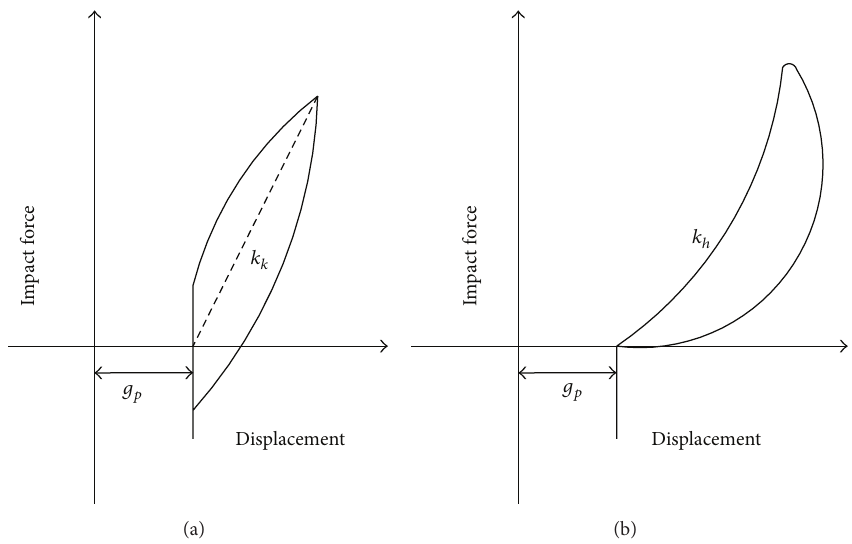
Figure 2: Contact force-displacement relationship for various impact models: (a) Kelvin model and (b) Hertz-damp model